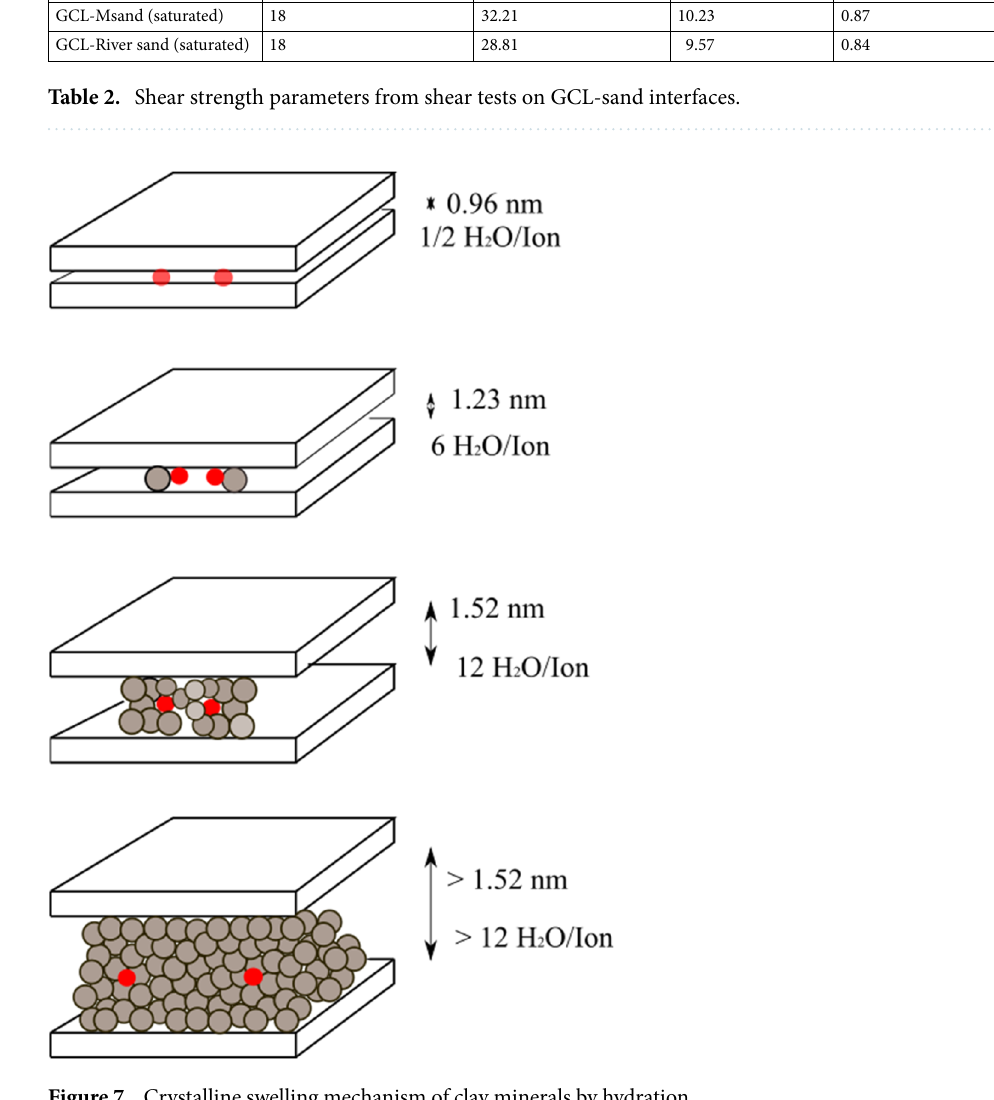
Figure 7. Crystalline swelling mechanism of clay minerals by